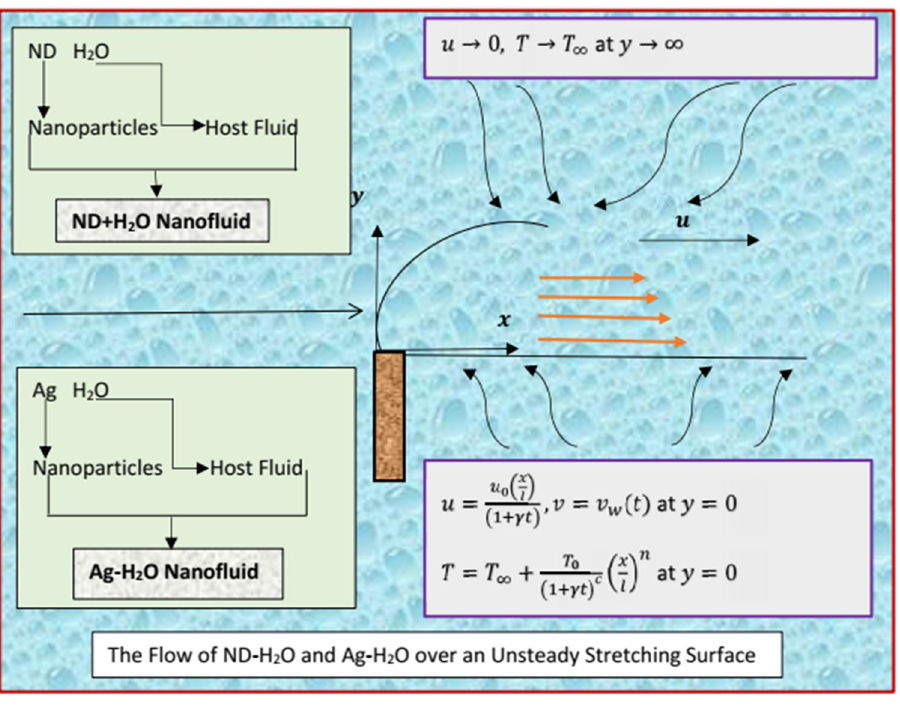
Figure 1. The Flow of nanodiamond-H 2 O and Silver-H 2